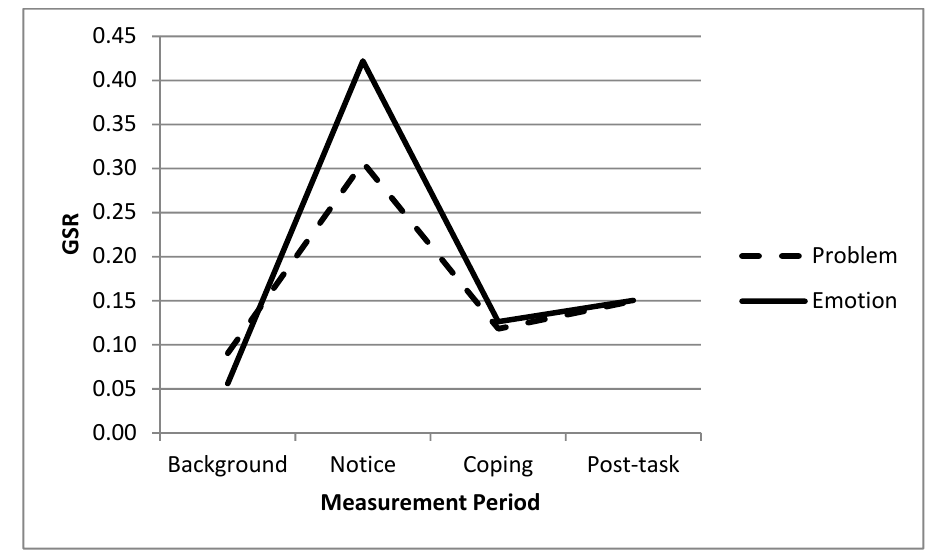
Figure 1. Coping method effects on GSR.